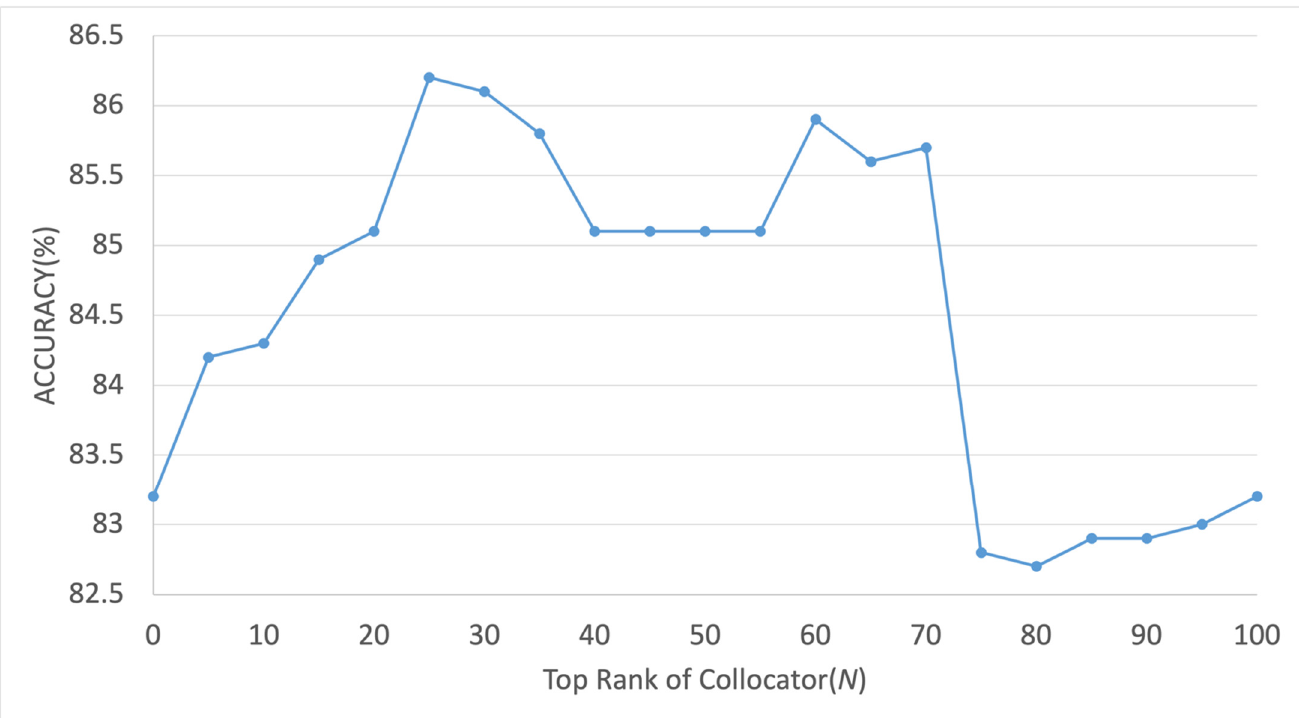
Figure 7. Change in accuracy due to expanded range of coordinate terms of the semantically related words of an ambiguous word.